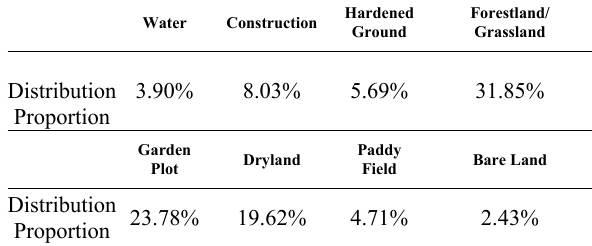
Table 1 Distribution Proportions of Main Land Types in